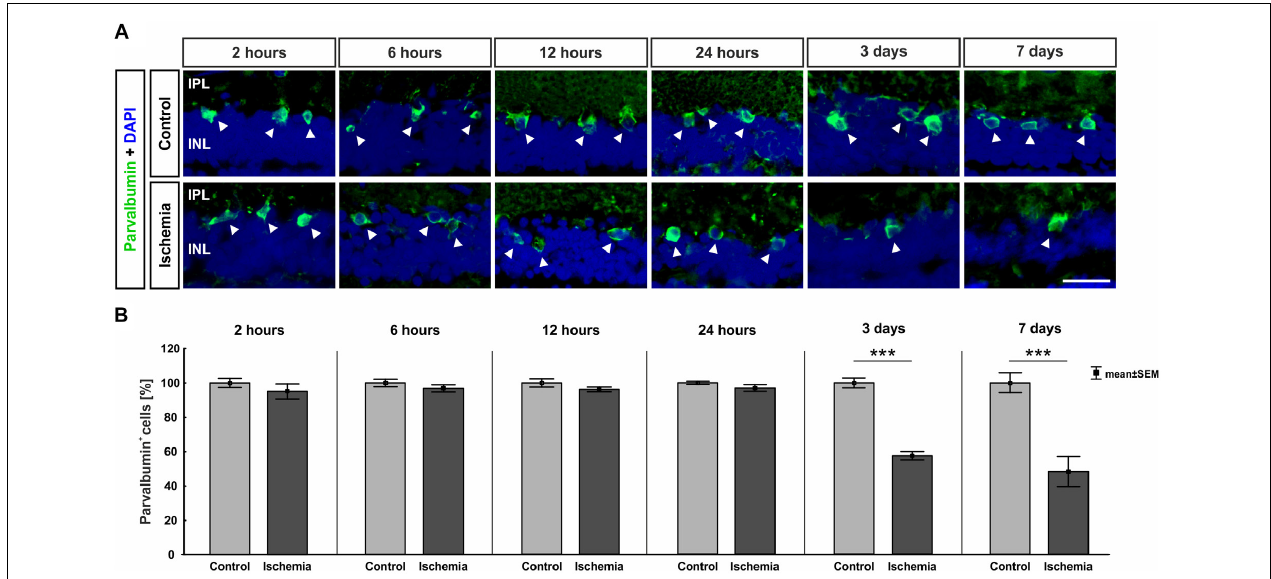
FIGURE 4 | (A) AII amacrine cells were marked with an anti-parvalbumin antibody (green, arrows), while DAPI was used to label cell nuclei (blue; n = 7–8/group). A lower number of parvalbumin + amacrine cells was noted at the later points in time. (B) A significant regression of parvalbumin + cells was detected 3 ( p < 0.001) and 7 days ( p < 0.001) after ischemia. ∗∗∗ p < 0.001. IPL, inner plexiform layer; INL, inner nuclear layer. Scale bar: 20 µ m. TABLE 6A | Analyses of the parvalbumin staining (%) at all points in time.